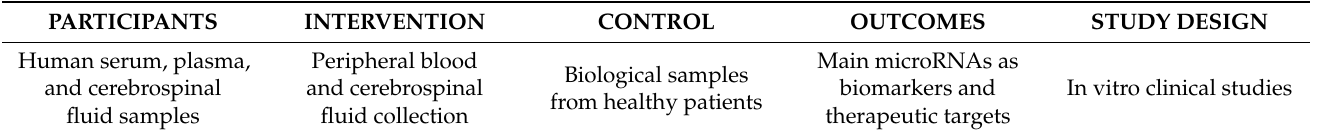
Table 1. Publication Search